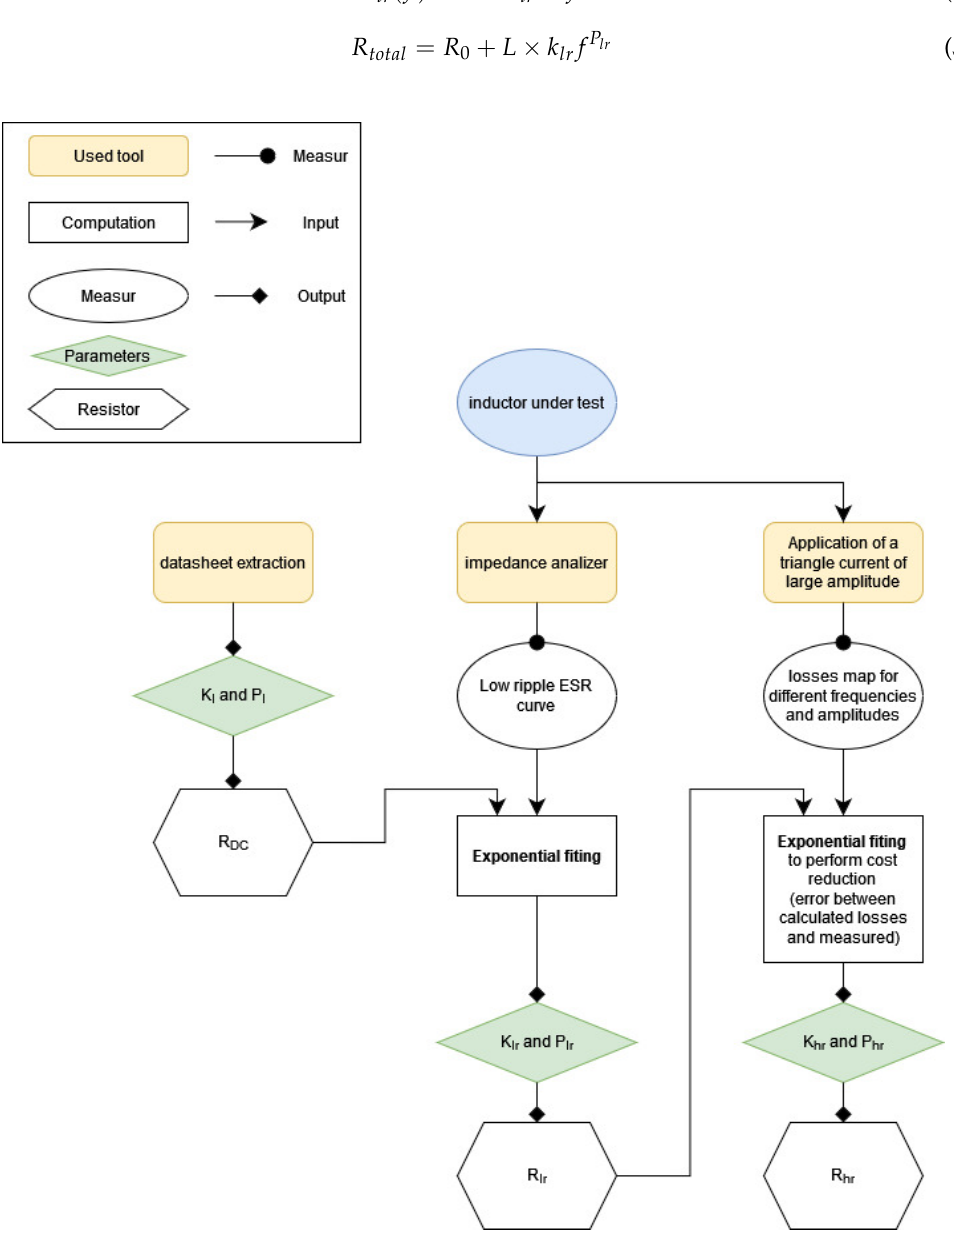
Figure 5. Characterization and modelling approach to derive the generic mathematical inductor losses model and corresponding parameters with respect to inductor value.